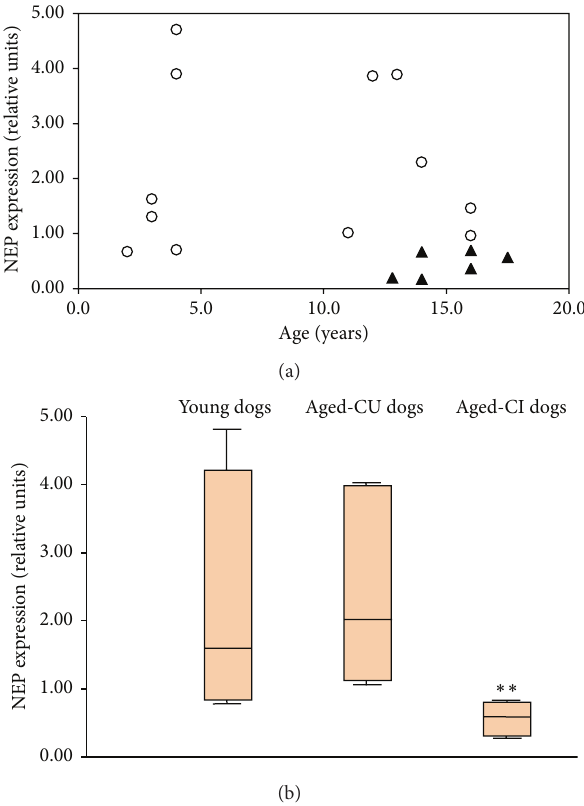
Figure 3: Statistical analysis of the correlation between cortical NEP mRNA expression and the number of cholinergic neurons in basal encephalon (a) and the extent of A 𝛽 deposits in gyrus proreus (b). A positive correlation exists between the number of cholinergic neurons of basal brain with the prefrontal NEP expression ( 𝑅 2 = 0.73 ), while no correlation is seen between NEP expression and insoluble A 𝛽 deposits in the same prefrontal cortex (in this diagram, dogs without A 𝛽 deposits belong to the young group). Cognitively healthy dogs are indicated with (o) and aged-cognitively impaired dogs with ( 󳵳